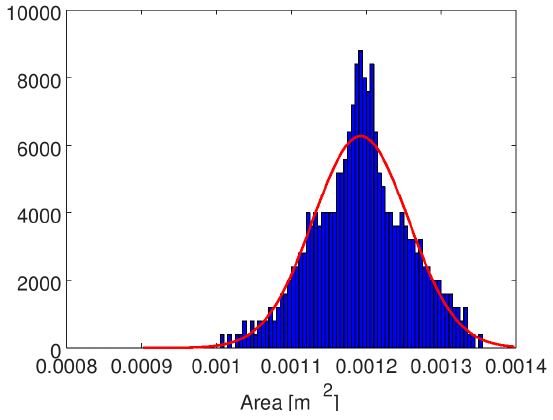
Figure 19. Pdf of plume area with normal input distribution of vf . Table 2. Main statistical moments for the output probability density function distributions.